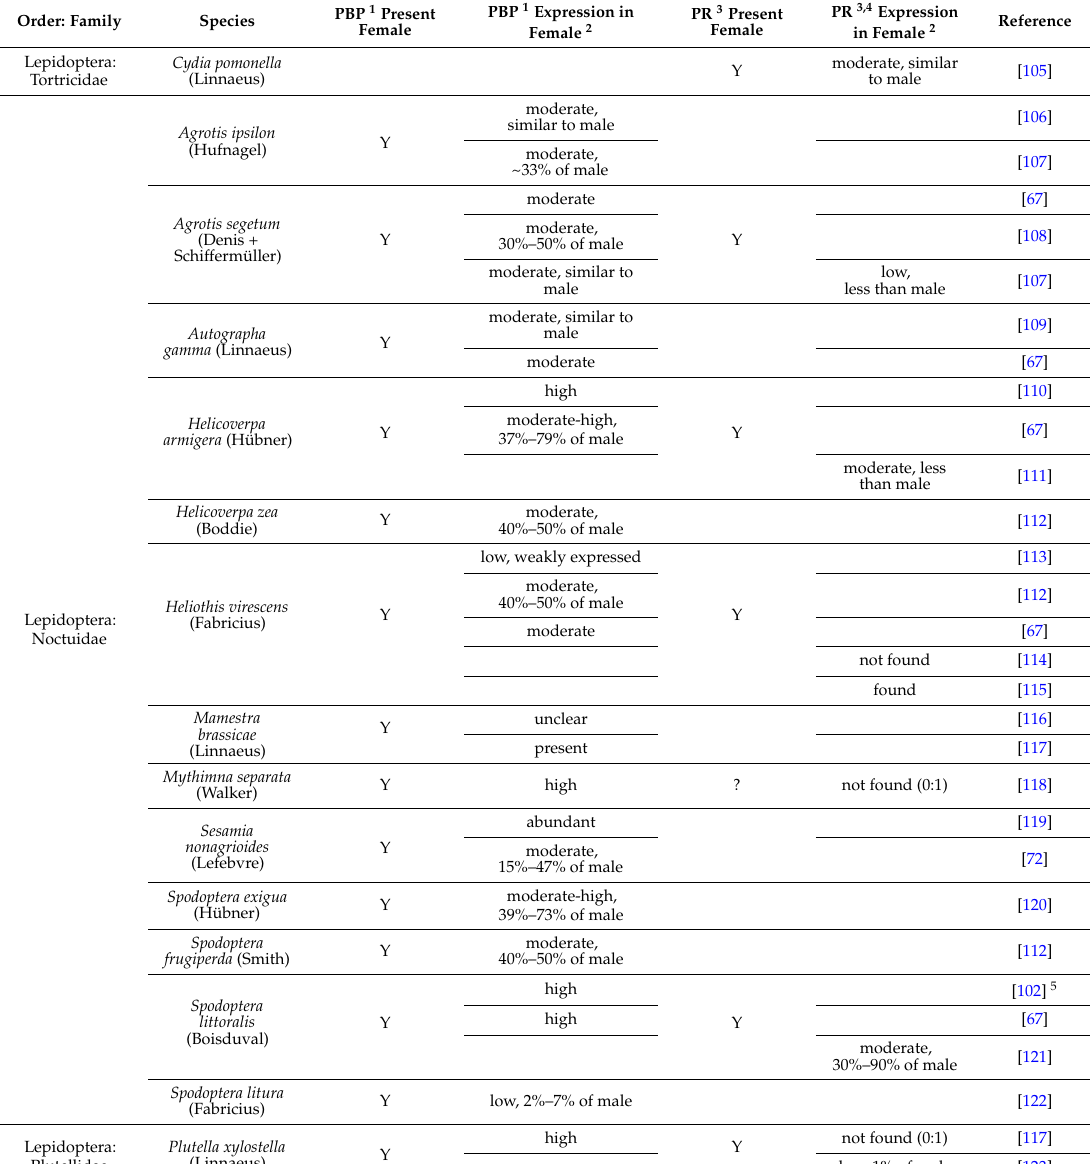
Table 3. Expression of pheromone-binding and pheromone-receptor proteins in female antennae to conspecific sex